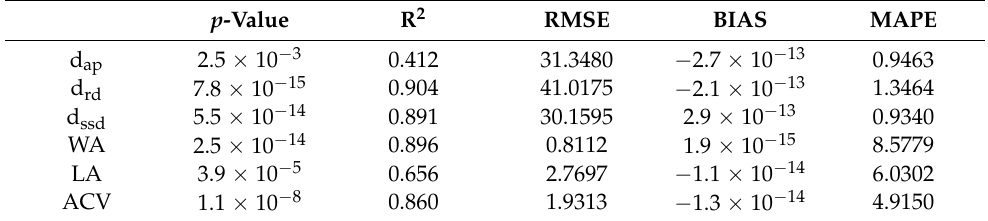
Table 4. Coefficients of determination (R 2 ), root-mean-squared error (RMSE), mean error (BIAS) and mean absolute percentage error